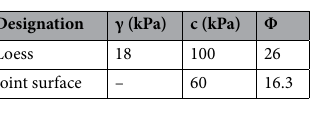
Table 2. Mechanical parameters of the